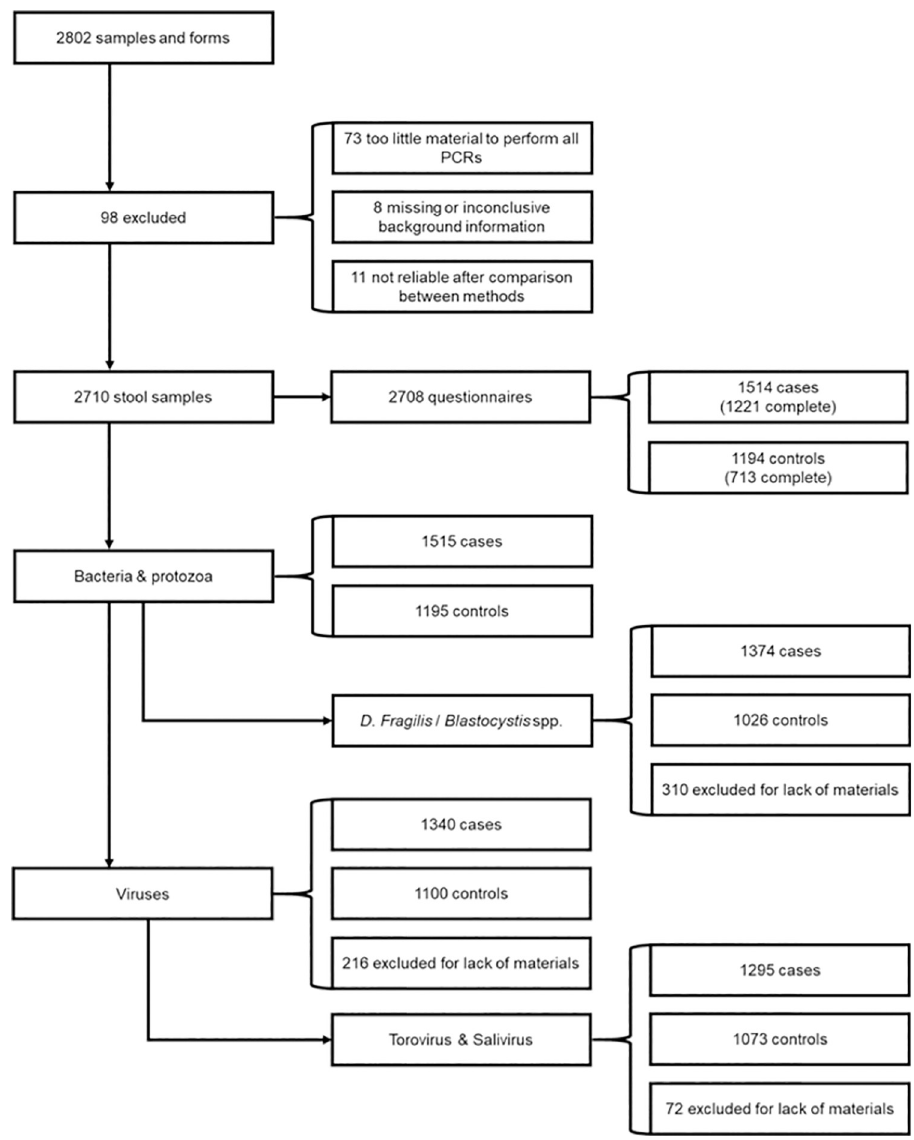
Fig 1. Flow scheme of the materials used in this study and